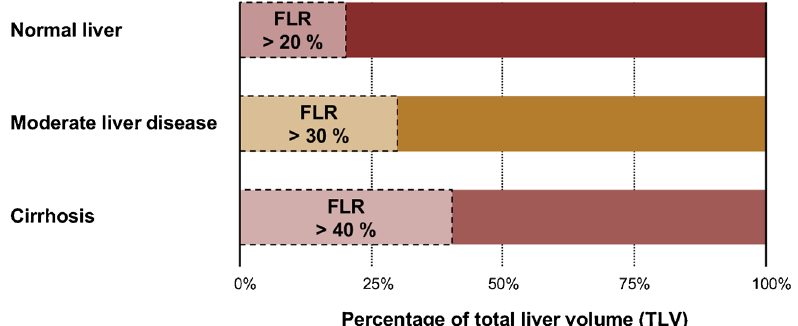
Fig. 3 Schematic of functional liver remnant (FLR) over total liver volume (TLV) ratio prior to hepatectomy. To be considered safely resectable prior to hepatec- tomy, the FLR/TLV ratio must be >20% in underlying normal livers, >30% in moderately dis- eased livers and >40% in cirrhotic